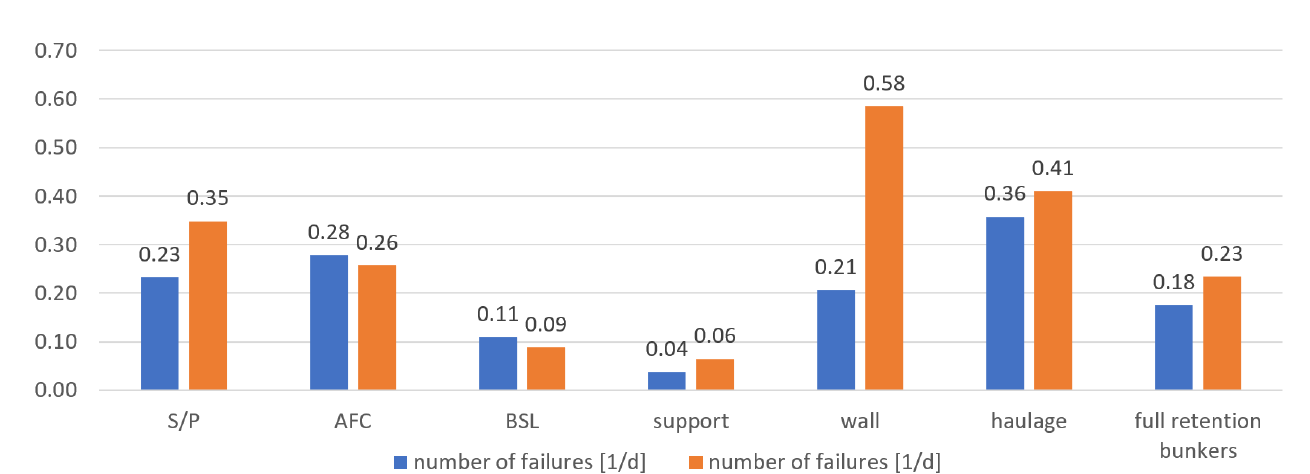
Figure 12. Comparison the total number of failures per one day of longwall operation.